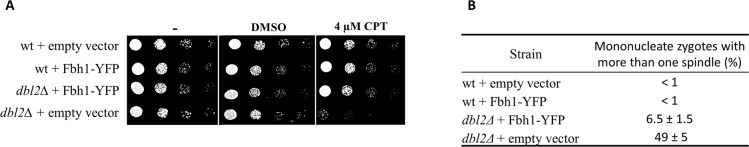
Overexpression of Fbh1 suppresses the dbl2Δ mutant phenotype.(A) Wild-type and dbl2Δ strains expressing either Fbh1-YFP (JG18021, JG18022) or empty vector (pREP41) (JG17953, JG17955) were grown in EMM2 liquid medium for one day, diluted in 5-fold steps, and spotted onto EMM2 plates lacking thiamine and containing the indicated amounts of camptothecin (CPT). The plates were photographed after 4 days of incubation at 32°C. (B) Strains described in panel (A) were mated on SPA sporulation plates, fixed after 10–17 hr and immunostained for tubulin. DNA was visualized by DAPI. Mononucleate zygotes with more than one spindle were scored in three sets of 100 meiotic cells. The values reported are means of three independent experiments ± SEM.